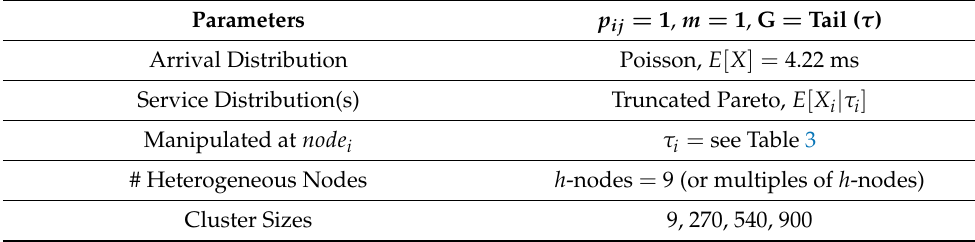
Figure 5. HFJQNs of nine distinct tails applied at all fork nodes, where the white- and black-box methods’ prediction performance are compared at load 90%. Table 2. HFJQNs of nine tails associated with all nodes.